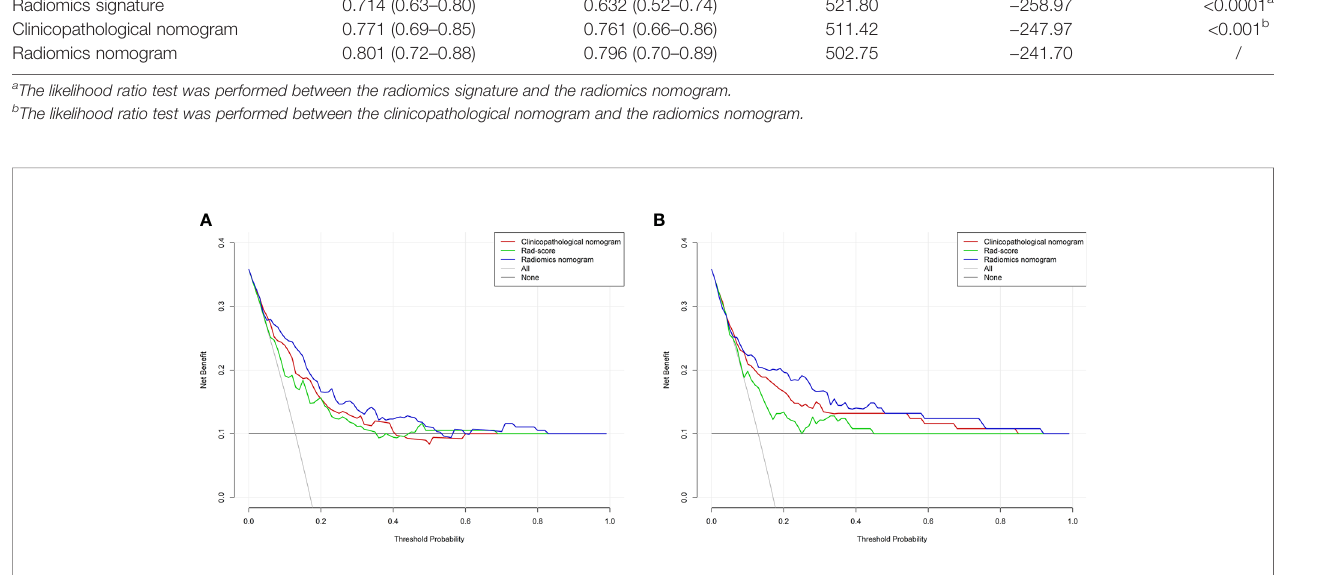
FIGURE 4 | Decision curve analysis for each model in the training (A) and validation (B) cohorts. The y-axis measures the net bene fi t. The net bene fi t was calculated by summing the bene fi ts (true positive results) and subtracting the harms (false positive results), weighing the latter by a factor related to the relative harm of an undetected cancer compared with the harm of unnecessary treatment. The radiomics model had the highest net bene fi t and simple strategies such as follow-up of all patients (gray line) or no patients (horizontal black line) across the full range of threshold probabilities at which a patient would choose to undergo imaging